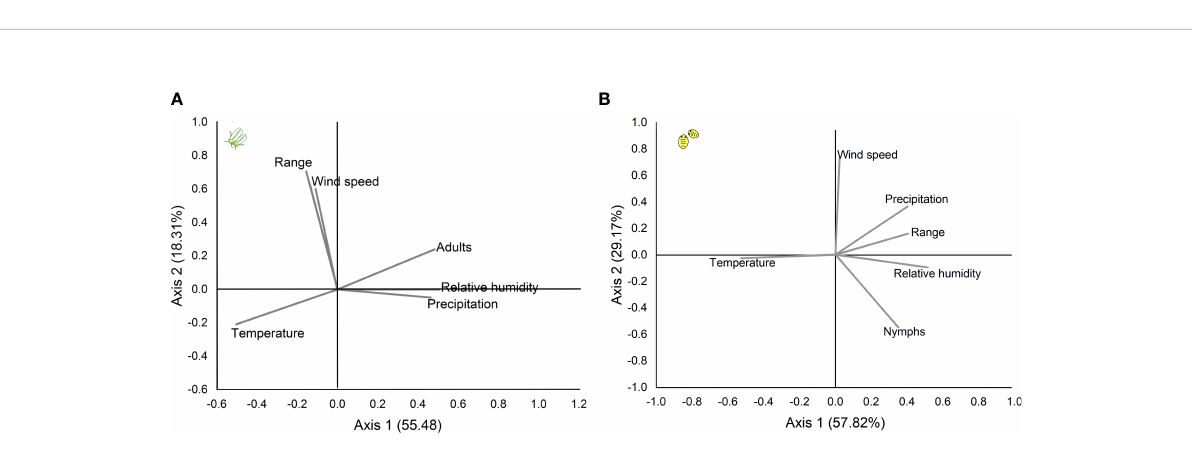
FIGURE 6 Principal component analysis of the effects of rainfall and climate elements on the range and abundance of (B) tabaci in soybean crops (A) for adults and (B) for nymphs. The fi rst and second axes explained 74.79% and 86.99 of the date variance for adults and nymphs,